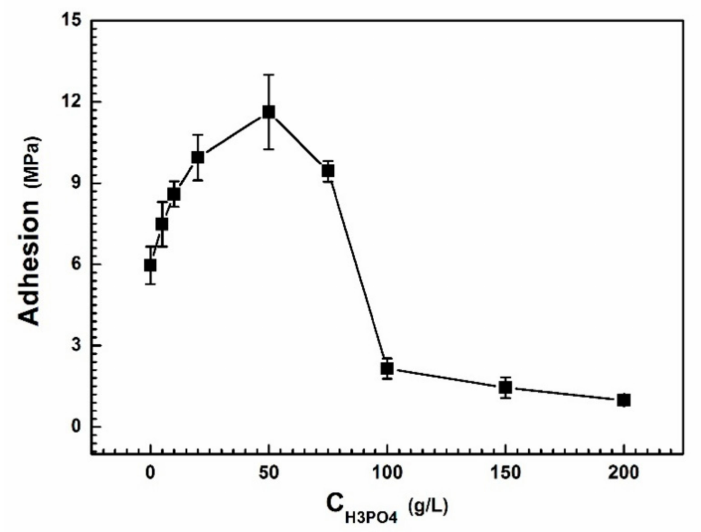
Figure 1. Variation of the adhesion strength with different concentrations of phosphoric acid (bars donate